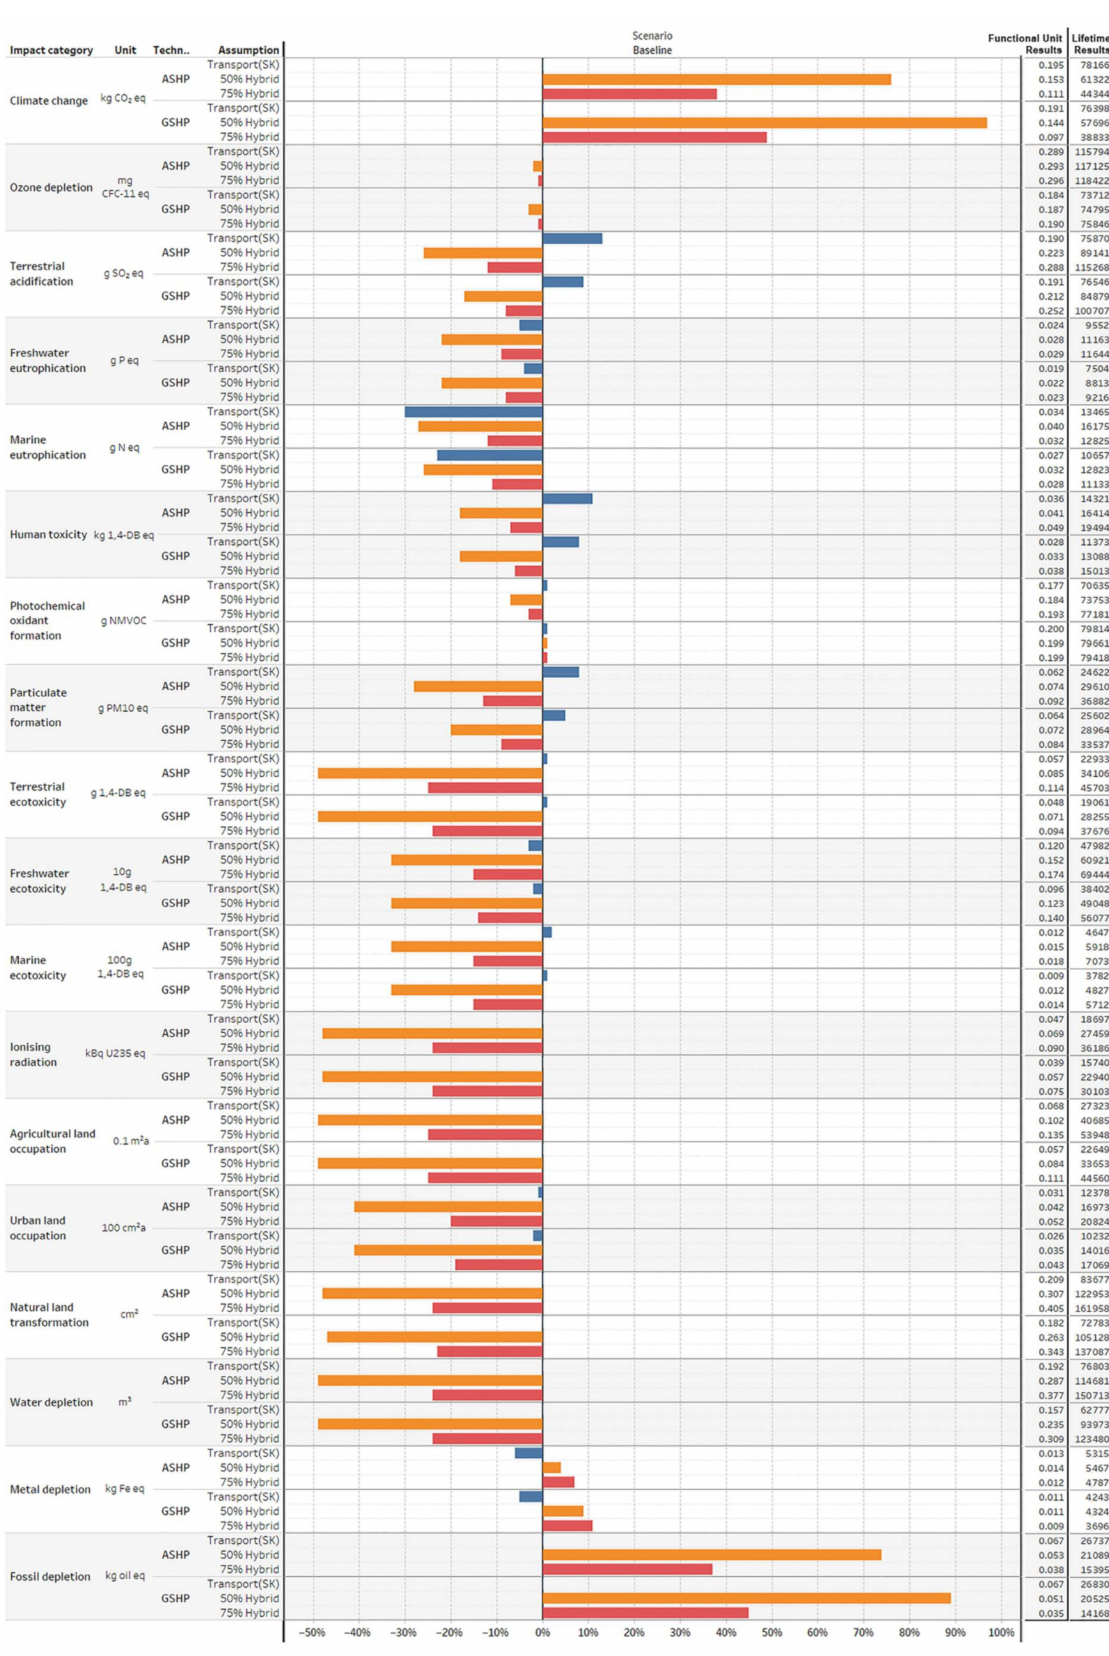
Figure 5. Lifecycle environmental impact change of Transport (SK) and Hybrid scenarios according to baseline